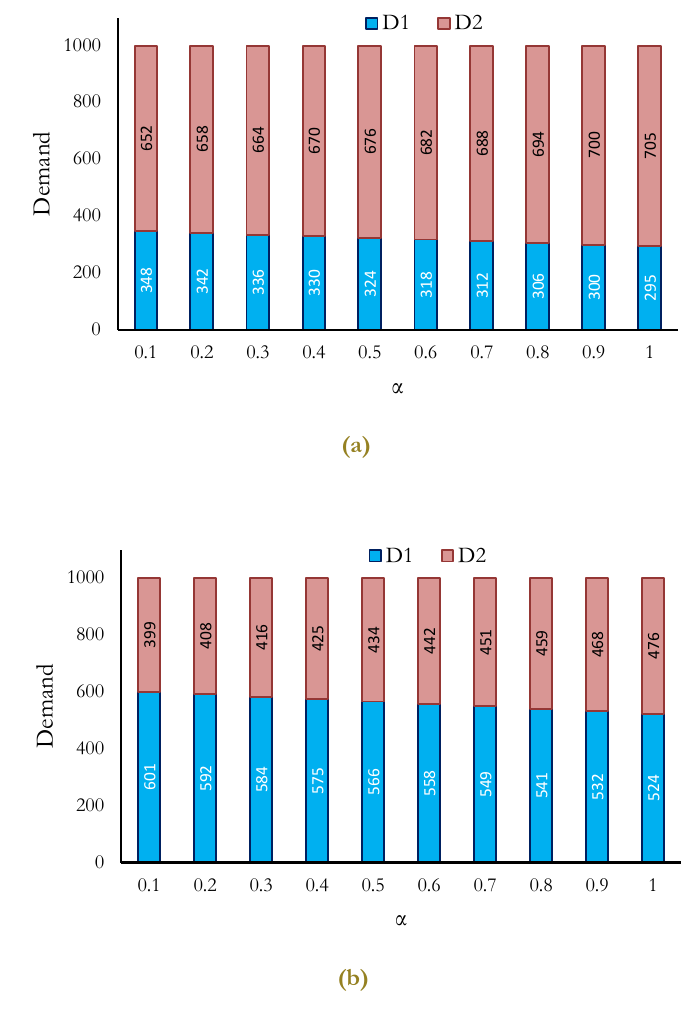
Fig. 4. The impact of α on demand for dental centers: (a). λ = 0 ; (b). λ = 1